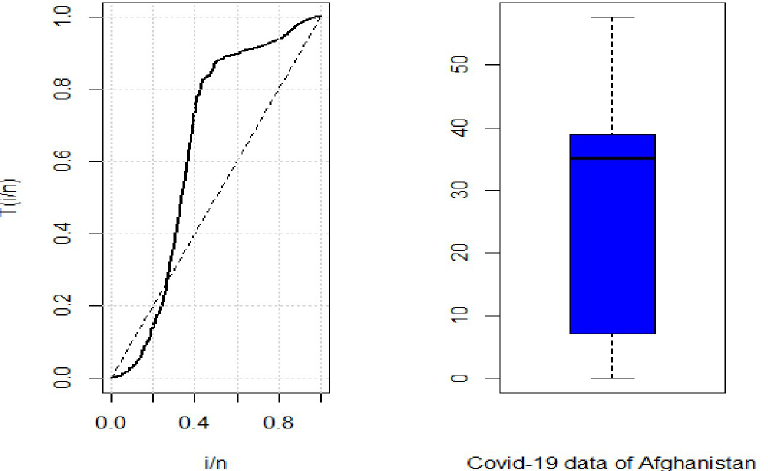
Fig 8. TTT and box plot of Covid-19 data for